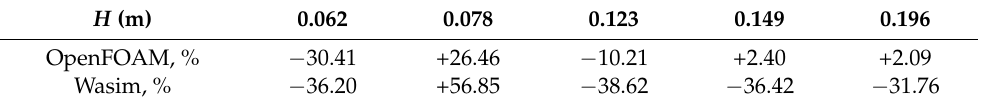
Table 10. Difference of numerical and experimental pitch transfer functions for the KRISO containership.